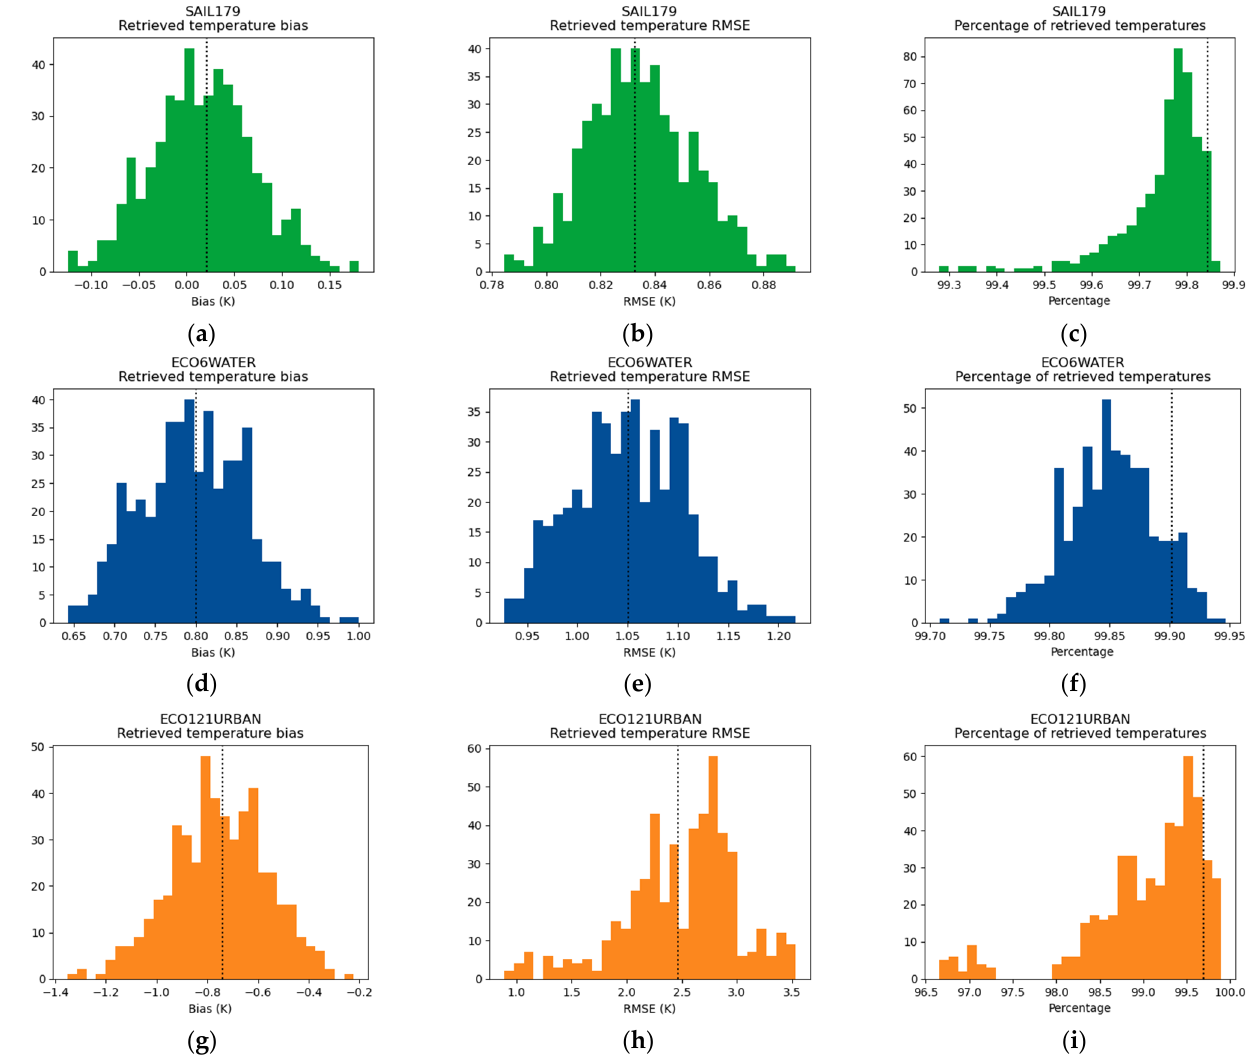
Figure 14. Bias, RMSE, and retrieved percentage obtained with DirecTES and ∆ T thresh = 3 K, with TIR information only, both sources of uncertainty, and 500 random divisions of the spectral library for vegetation ( a – c ), water ( d – f ) and urban materials ( g – i ). The dashed line represents the value obtained without dividing the spectral library.